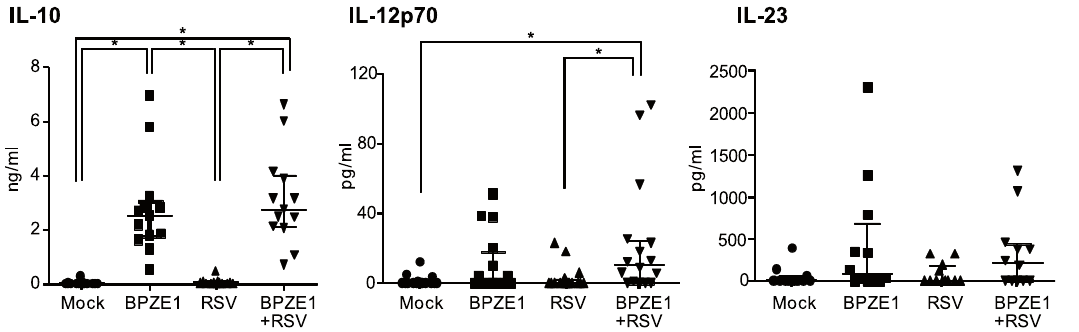
Figure 2. Impact of BPZE1 on IL-10, IL-12p70 and IL-23 production of RSV-infected MDDC. MDDC were treated with BPZE1 (bacteria/cell ratio of 100:1), RSV (MOI of 1) or double infected with BPZE1 and RSV. Mock-infected cells were used as control. After 24 h, cytokines released in the culture media were measured by ELISA. Values are expressed as medians with interquartile range from 13 (IL-10 and IL-23) and from 15 (IL-12p70) independent experiments performed with MDDC obtained from different donors and expressed as ng/ml (IL-10) or pg/ml (IL-12p70 and IL-23). Statistical significant differences are indicated by * ( P # 0.0083).